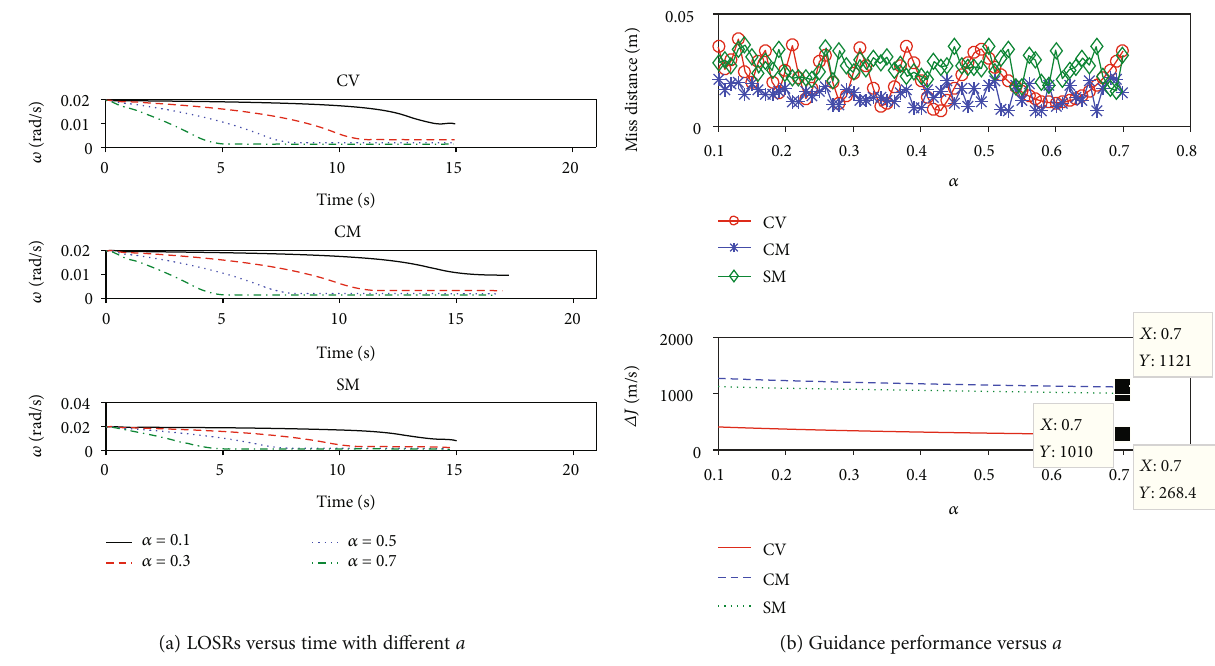
Figure 7: Intercept characteristics with pro fi le parameter — Case 1. Table 5: Initial state of the missile and the target. Initial